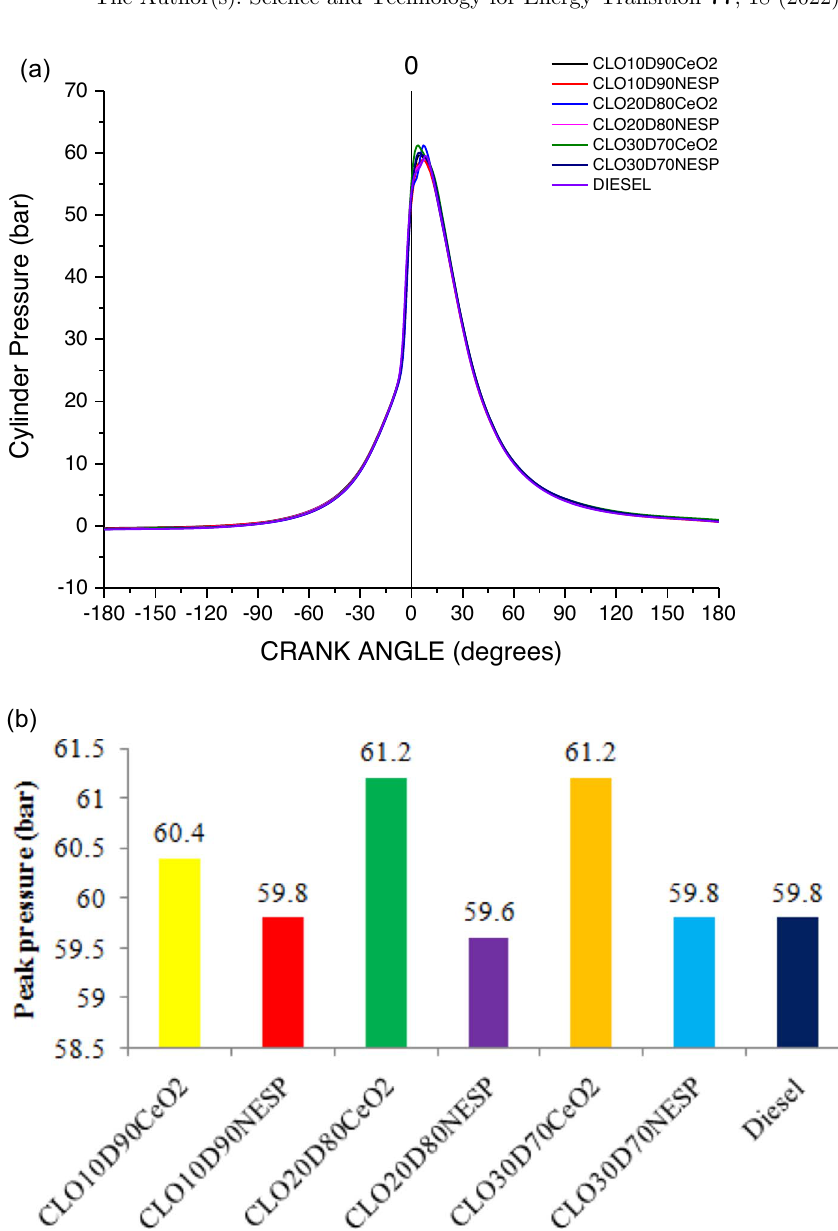
Fig. 4. (a) Cylinder pressure versus CA plot. (b) Maximum cylinder pressure for the diesel blends. (c) HRR versus CA plot.